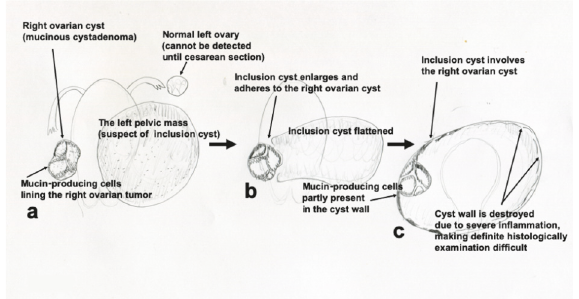
Figure 4: Schematic presentation of enlargement of the inclusion cyst. (a) At 9 weeks, the right mucinous cystadenoma and left cyst (later diagnosed as an inclusion cyst) existed independently. (b) During gestation progressing, the inclusion cyst became larger. The right ovarian cyst and inclusion cyst became close. (c) Finally, the right ovarian cyst was involved in the inclusion cyst. Mucin- producing cells were observed mainly on the near-side of the right ovarian cyst. The wall of the inclusion cyst was largely destroyed due to inflammation, which made it difficult to conduct a detailed histological examination such as the confirmation of mesothelial cells in the inclusion cyst